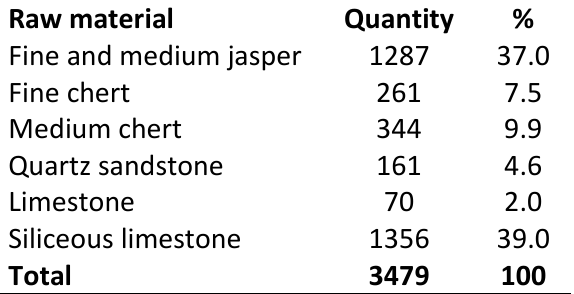
Table 1. Lithological classes. 4025 pieces, because of their tiny dimension (mostly micro flakes and debris of the first and second DC), are excluded from the